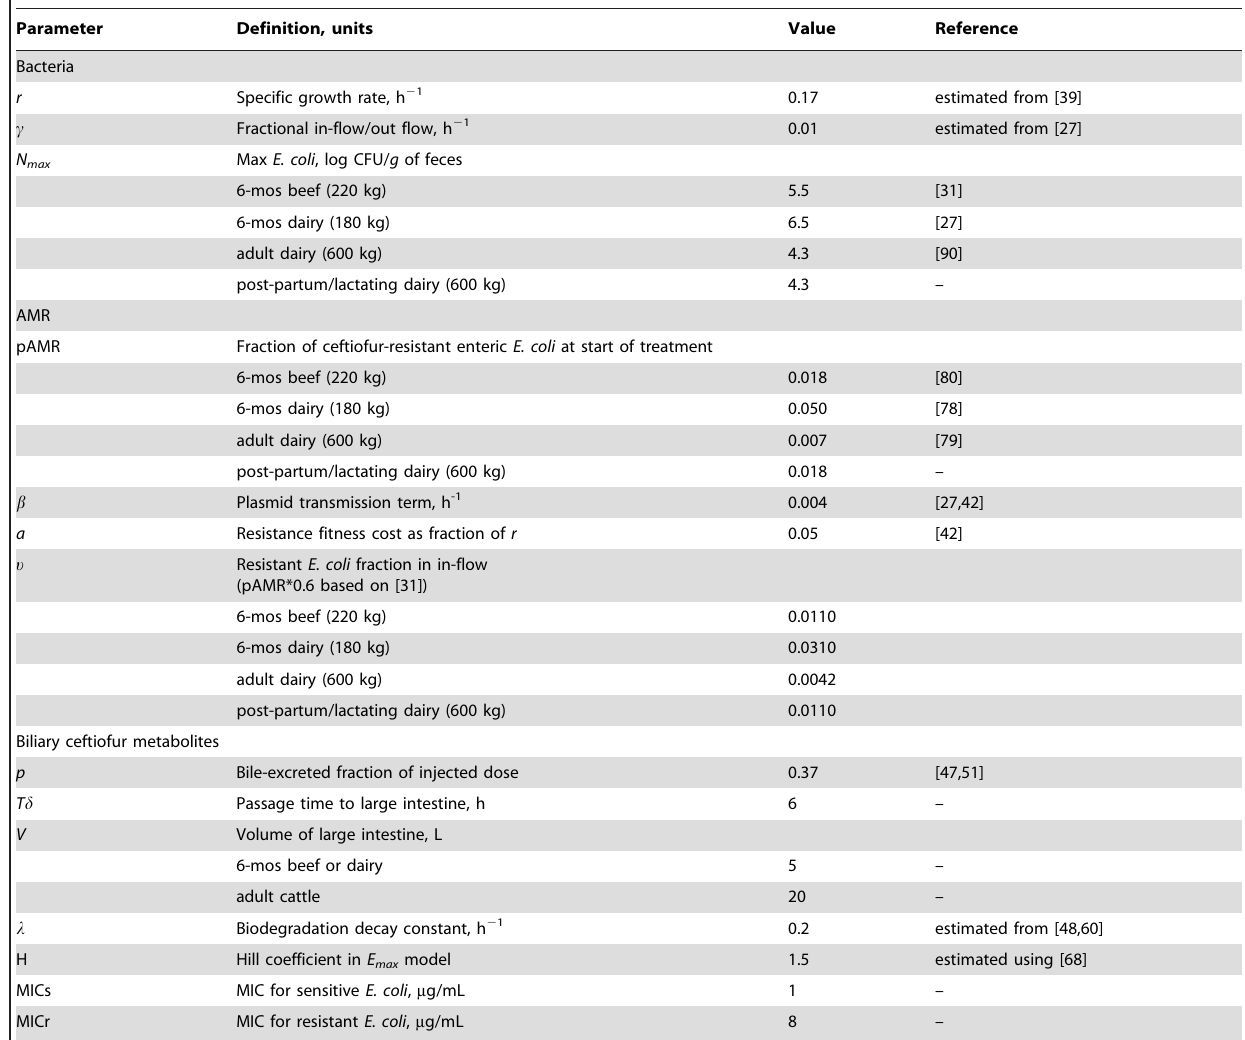
Table 1. Parameter definitions and